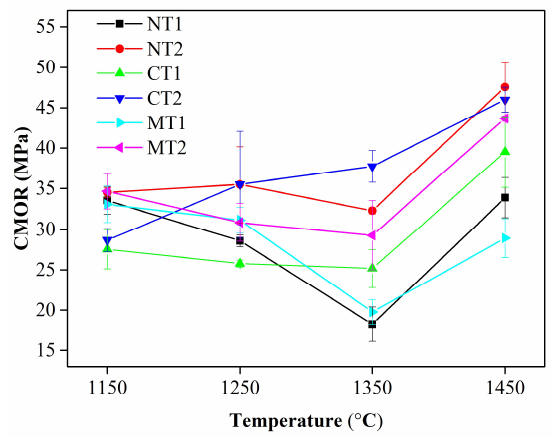
Figure 8. Variation of cold modulus of rupture for the castables with calcination temperatures.